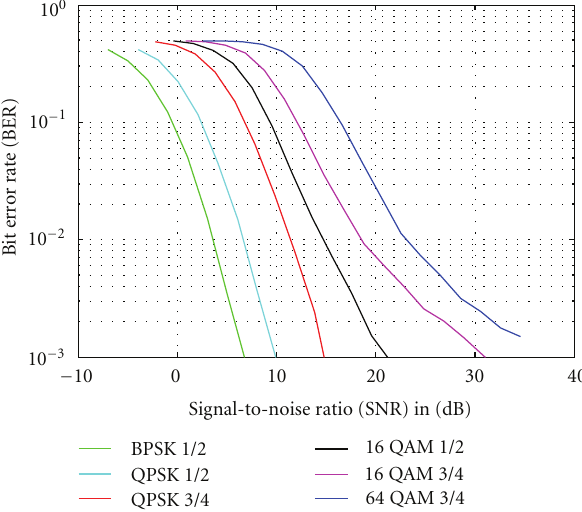
Figure 13: BER performance of DSA-SINR across di ff erent MCSs in a fully correlated